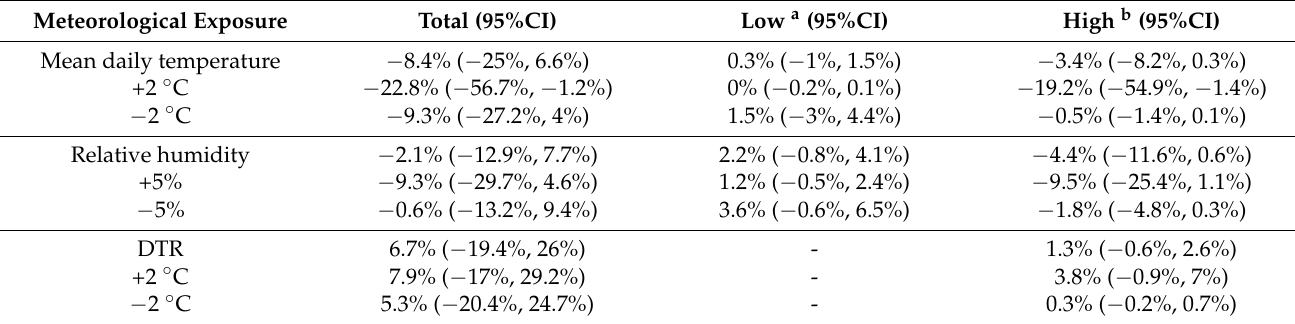
Table 1. Proportion of pneumonia hospital admissions attributable to changes in meteorological exposures (AF = attributable fraction), shown as the total AF, the AF due to lower values of the exposures, and the AF due to higher values of the exposures. ± changes in meteorological expo- sures indicate how the AF would change if the exposure distribution was shifted positively or negatively by the specified amount.